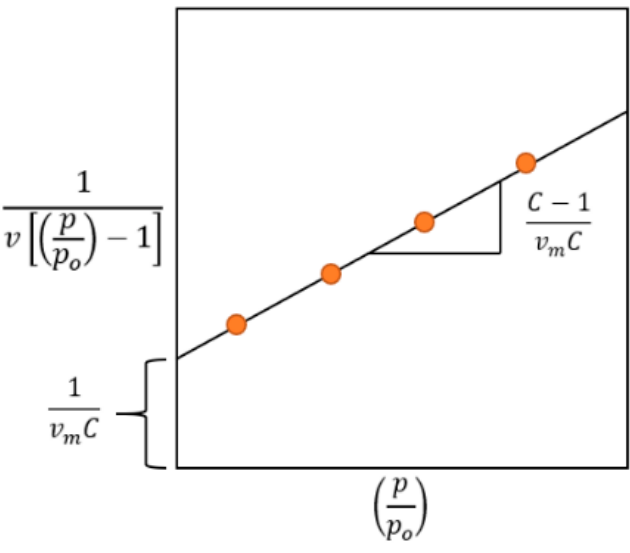
Figure 7. Linear plot for BET method.